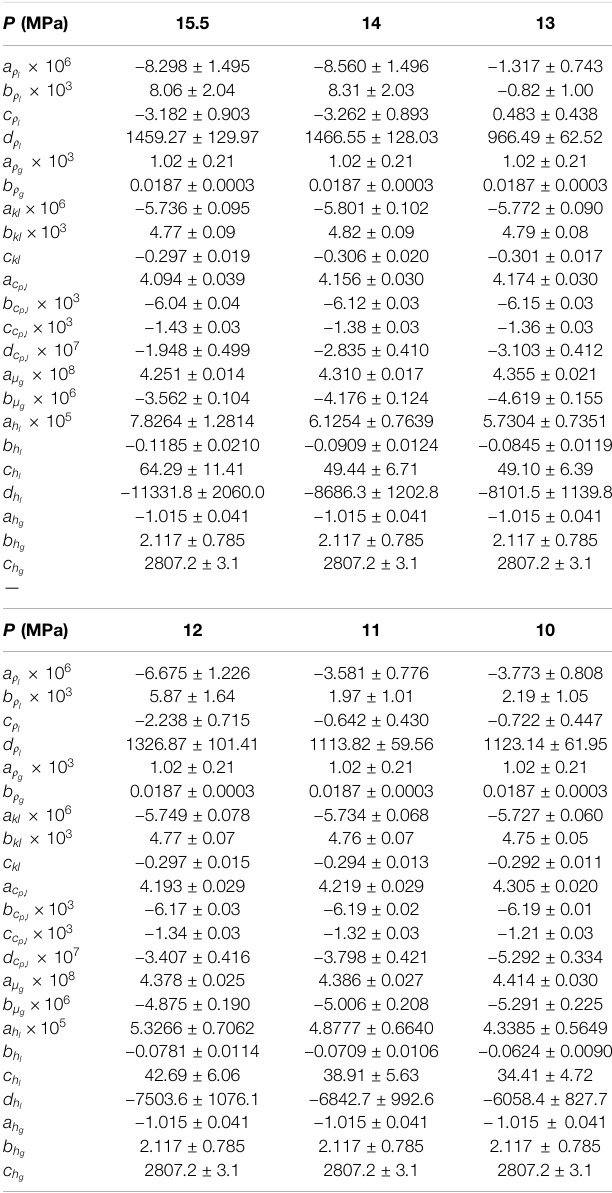
TABLE 1 | Values of coef fi cients for the calculation of coolant properties under 15.5, 14, 13, 12, 11, and 10